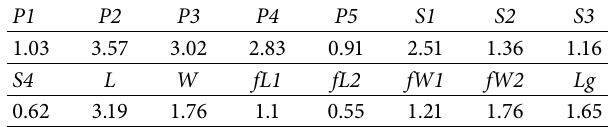
Table 1: Dimensions of the proposed single element.